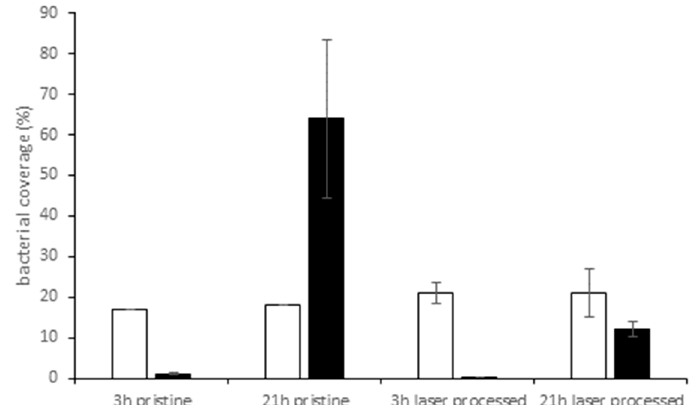
Figure 5. Bacterial coverage (%) on pristine or laser processed PE samples after co-cultivation for 3 h or 21 h. (cid:3) S. aureus , (cid:4) E. coli (weighted mean values and standard deviations, repetitions: obtained from five images for S. aureus , obtained from three images for E. coli ). Note that for the pristine surfaces, the standard deviation is negligible since the bacteria were evenly distributed on the surface.